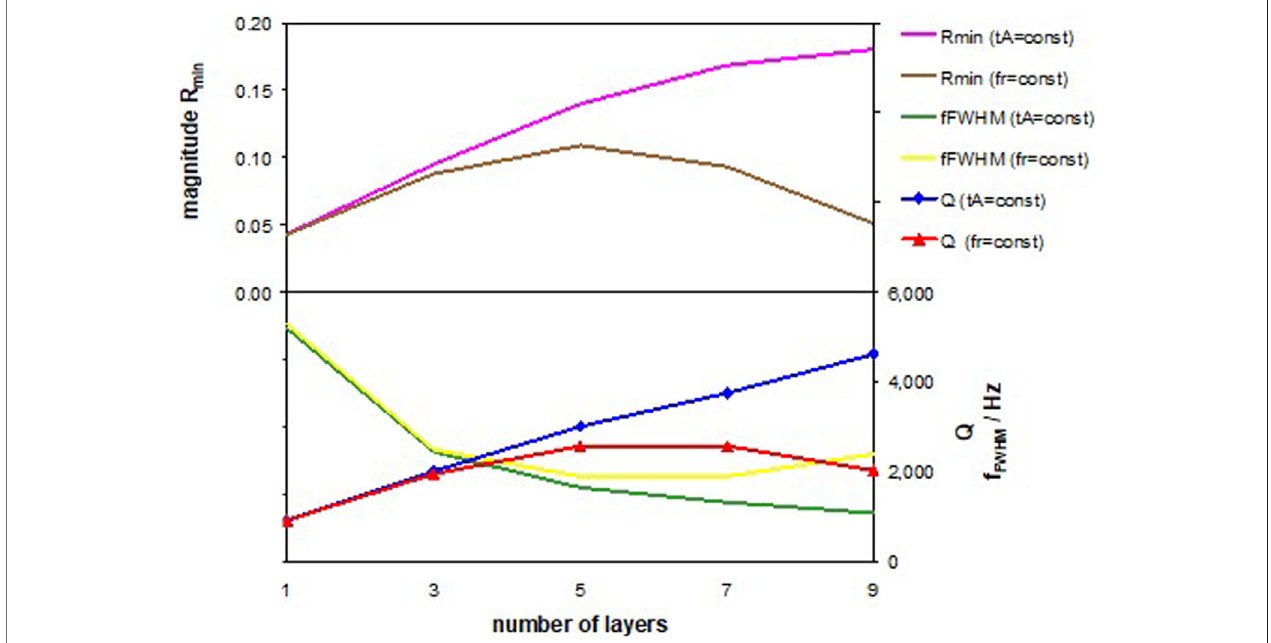
FIGURE7| DependenceofthecharacteristicPnC-values R min , f FWHM ,and Q onthenumberoflayersfortwosetups:atconstantanalyte,layerthickness, t A ,andat constant resonance frequency, f res .